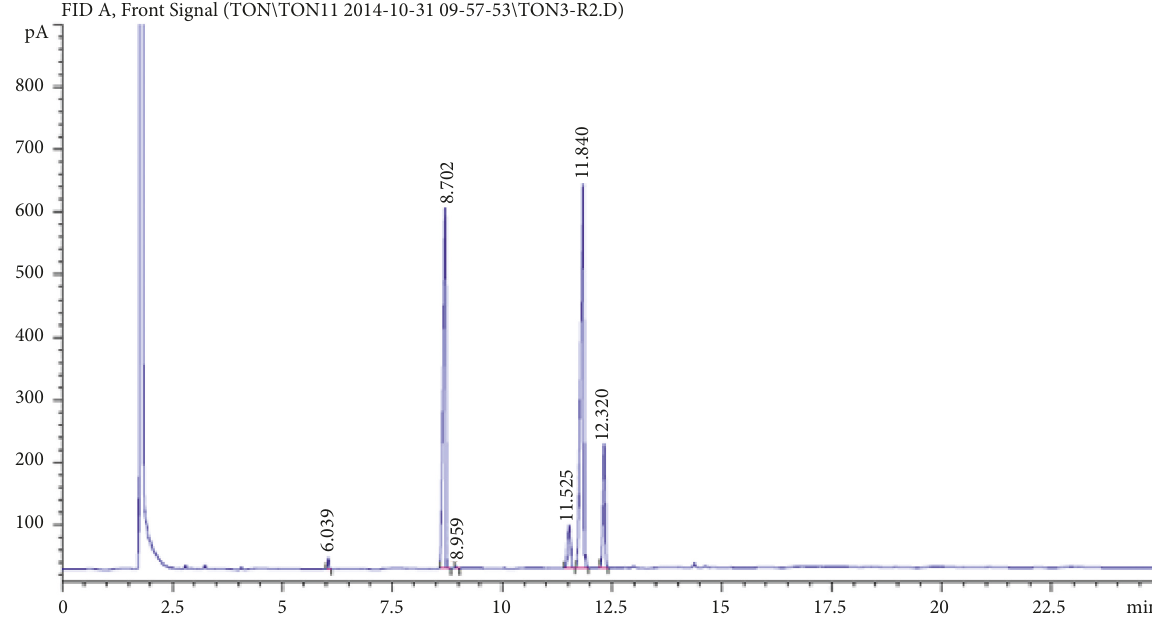
Figure 7: GC/FID chromatogram showing the fatty acid composition of palm olein. Identified fatty acids: myristic acid (C14: 0) (1.75%, retention time: 6.030); palmitic acid (C16:0) (37.65%, retention time: 8.702); palmitoleic acid (C16:1) (0.15%, retention time: 8.959); stearic acid (C18:0) (4.75%, retention time: 11.525); oleic acid (C18:1) (46.09%, retention time: 11.840); and linoleic acid (C18:2) (10.55%, retention time: 12.320).